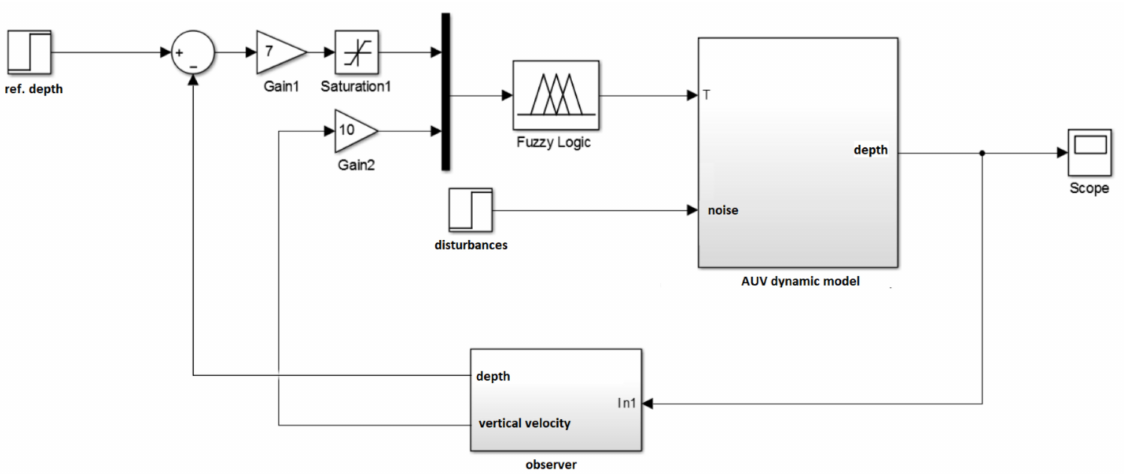
Figure 6. Simulation of an underwater robot using typical blocks of the Simulink package and proposed mathematical model.